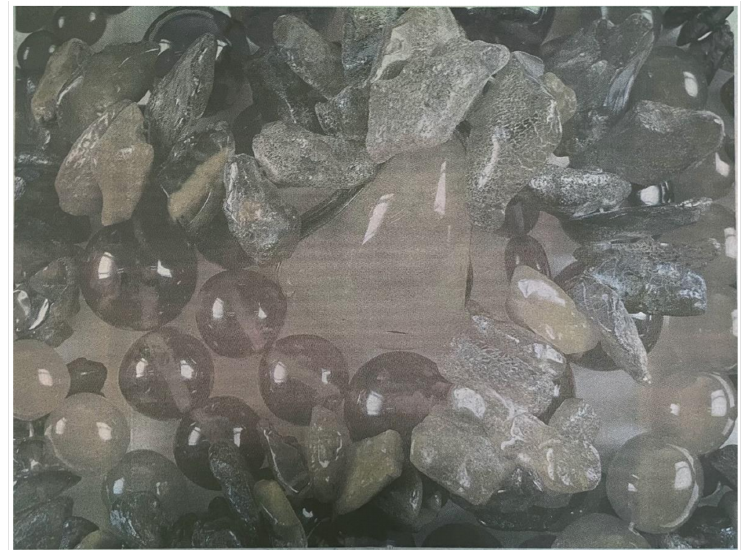
Figure A10. 25LPI, offset litho, Spectraval™ pigments, R = 2 × pass, G = 3 × pass, B = 3 × pass, black Plike, film negative, print size: 600 mm × 450 mm.